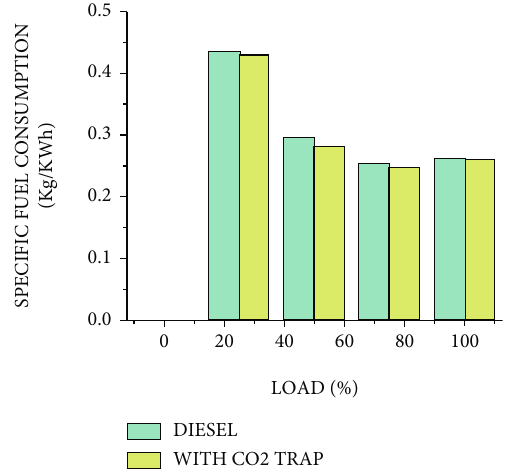
Figure 10: E ff ect of CO consumption.